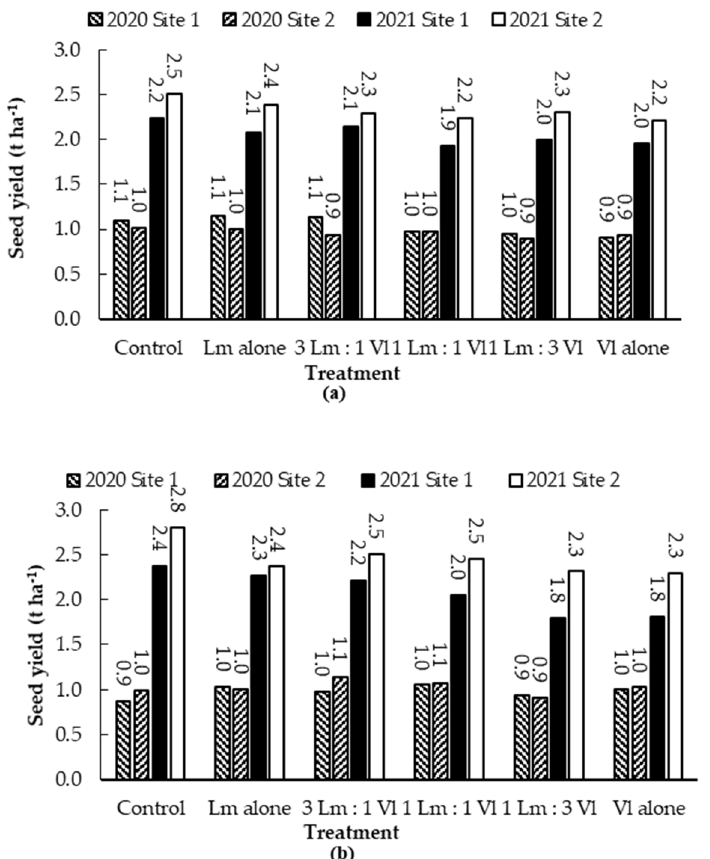
Figure 6. Mean seed yield of the canola hybrids ‘45H31’ ( a ) and ‘CS2000’ ( b ) under field conditions. Data were collected over two years (2020 and 2021) in Edmonton, AB, Canada, following inoculation with Leptosphaeria maculans ( Lm ) and Verticillium longisporum ( Vl ) alone or in various combinations (3:1, 1:1, 1:3). Values represent the mean of four replications for each year. Mean seed yields were not significantly different according to the Tukey-Kramer test ( p > 0.05) among any of the treatments.